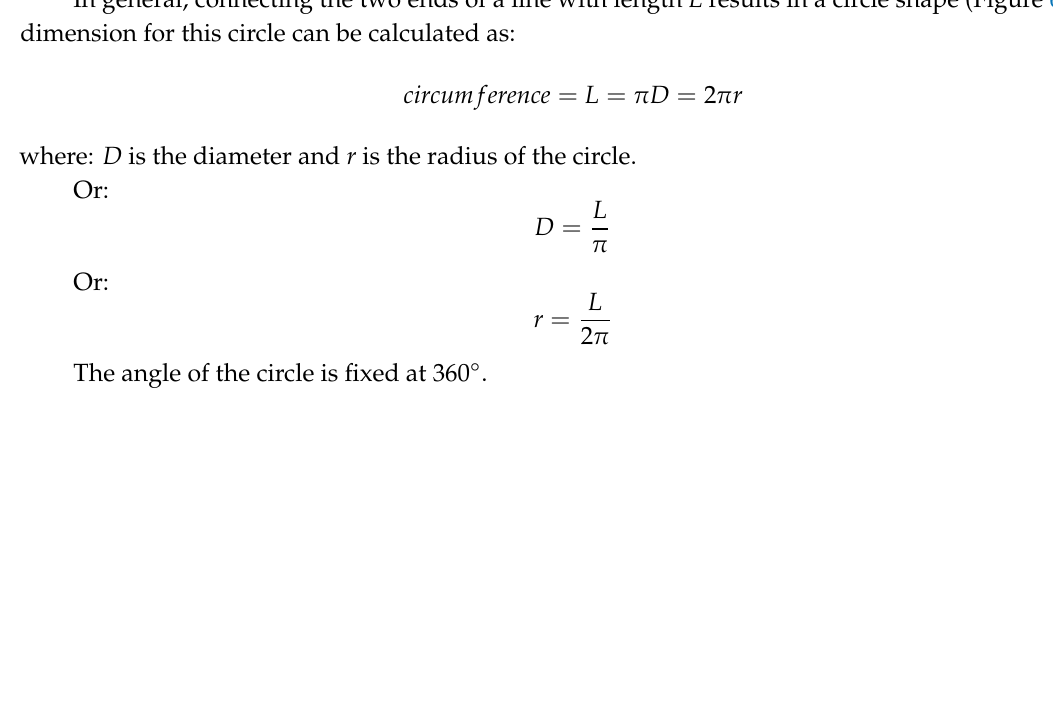
Figure 6. The line to circle conversion.